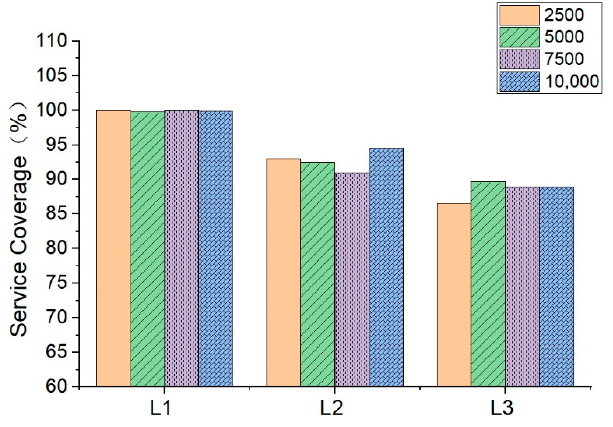
Figure 10. Service coverage.